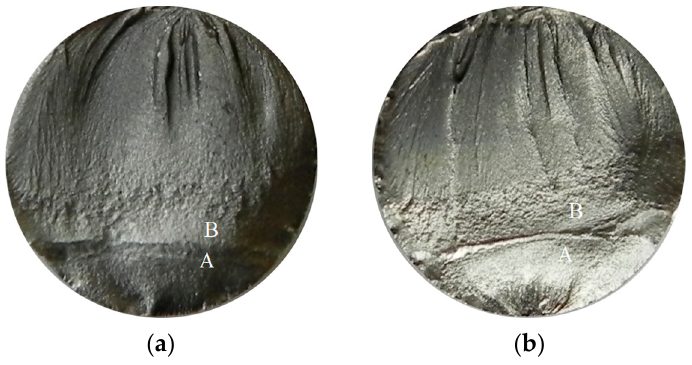
Figure 4. Fatigue fracture of exemplary samples from a series subjected to the solution in tap water, submitted to stress amplitude σ a = 162 MPa: ( a ) 7 days of immersion (Sample No. 3, Table 4); ( b ) 14 days of immersion (Sample No. 15, Table 5). Cracks originated from the bottom of the specimen, where: A—crack growth region, B—fast fracture